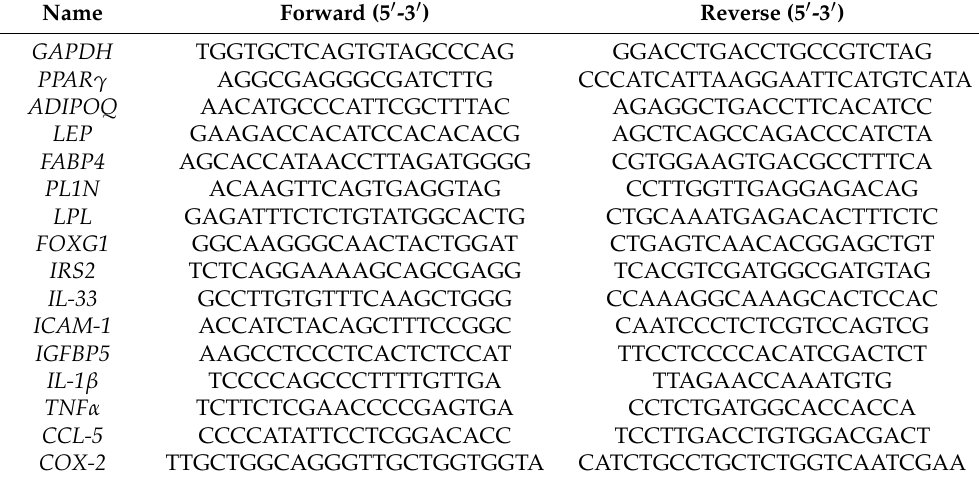
Table 2. Primer Sequences for